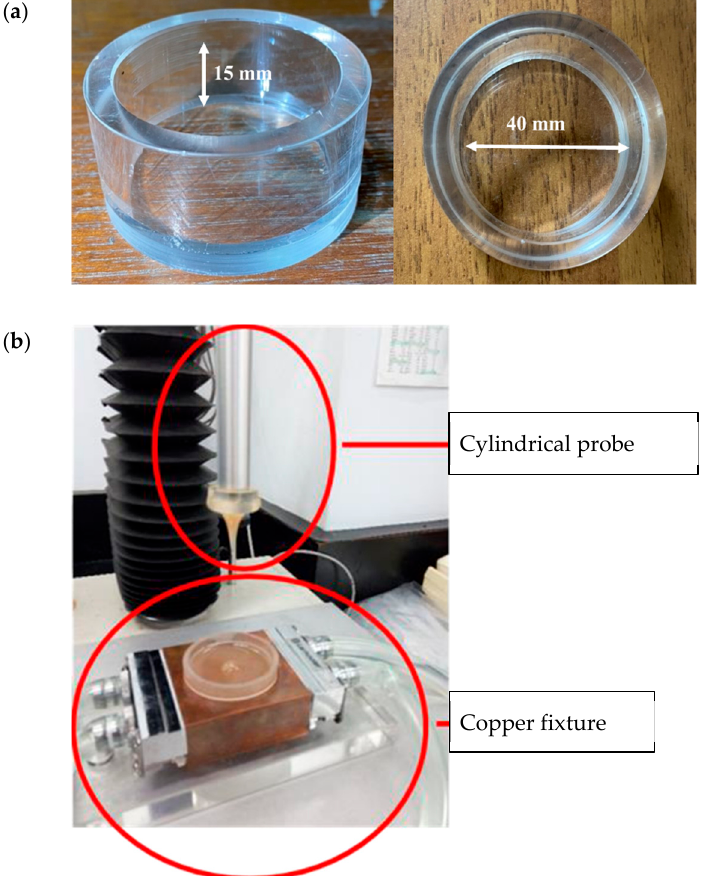
Figure 1. Experimental setup for texture profile analysis (TPA): ( a ) Sample container made of glass with the indicated dimensions. ( b ) Cylindrical probe and the copper fixture holding the glass container that is connected to a circulation system to maintain system temperature at 25 °C throughout the measurement.